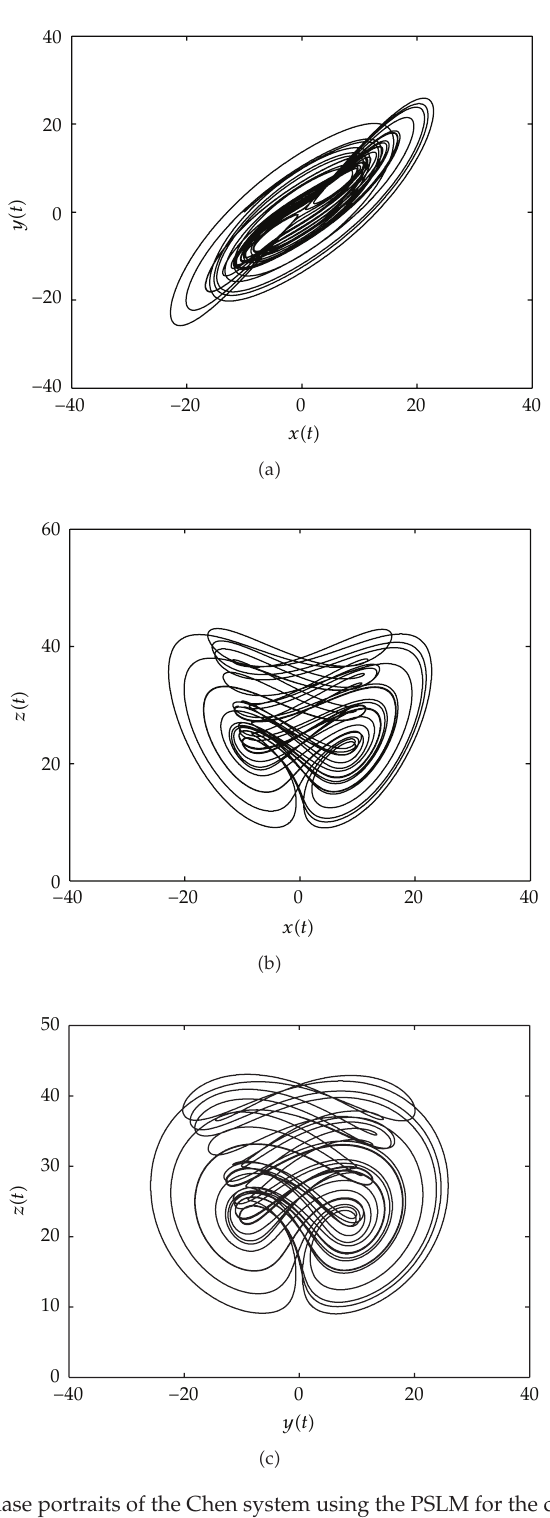
Figure 4: Phase portraits of the Chen system using the PSLM for the chaotic